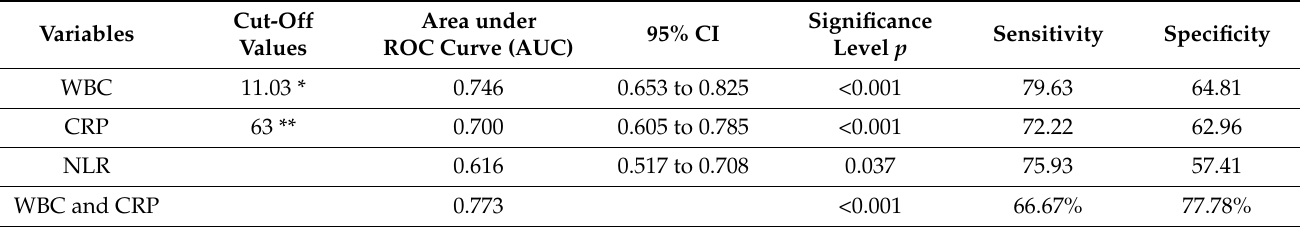
Table 4. ROC curve analysis for study variables and the cut-off values for WBC and CRP.